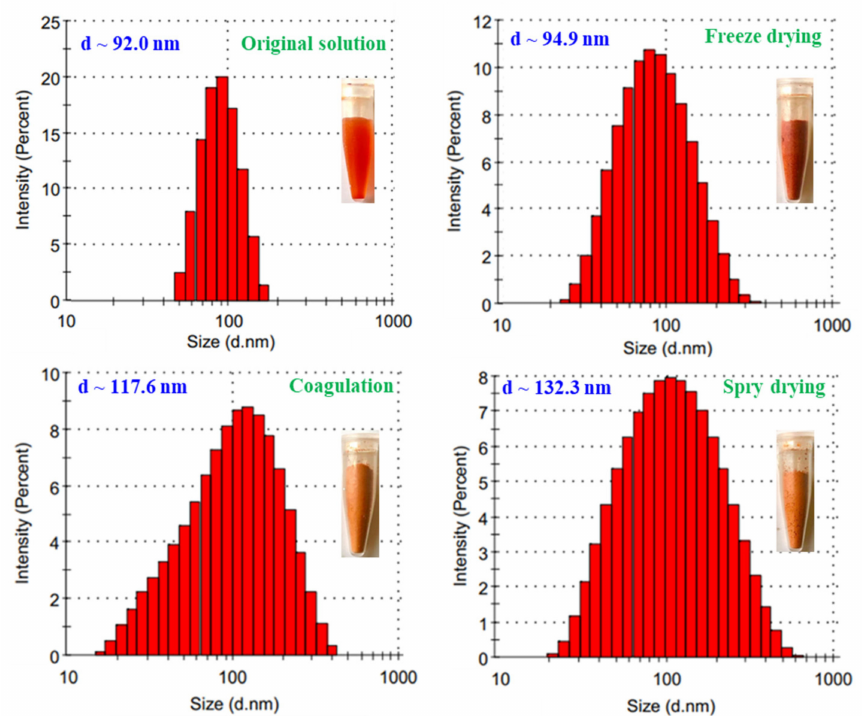
Figure 10. Particle size and size distribution of SeNPs/ β -glucan solution and after changing into powder form by different